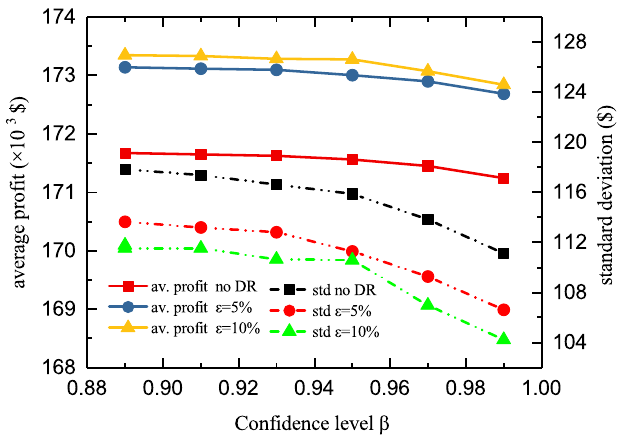
Figure 9. Average profit and standard deviation of profit for different load-shift capability.